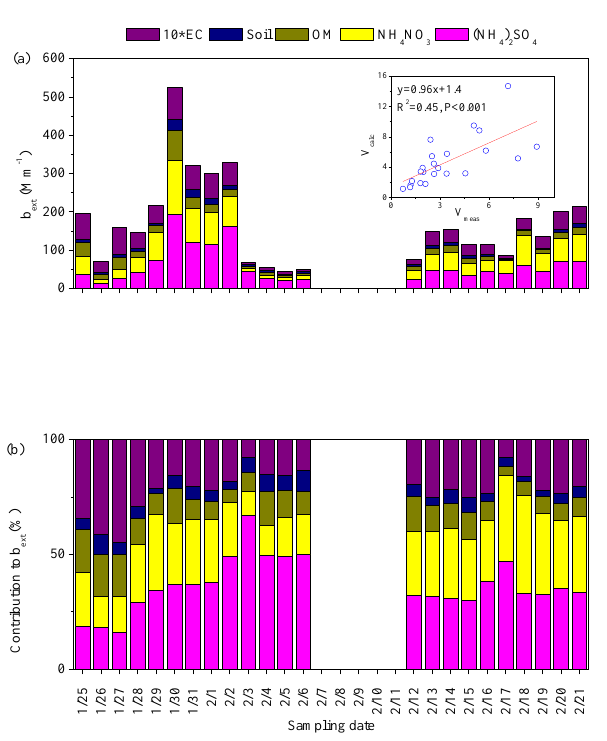
Figure 7. Extinction coefficients of chemical components in PM 2 . 5 in Nanjing (a) and relative contribution to light extinction of chem- ical components in PM 2 . 5 (b) . 30 January–7 February belongs to the Chinese Spring Festival in 2014; 30 January is the Chinese New Year day; 14 February is the Lantern Festival day. V cal indicates the visibility calculated by adding individual components; V meas is the measured visibility.